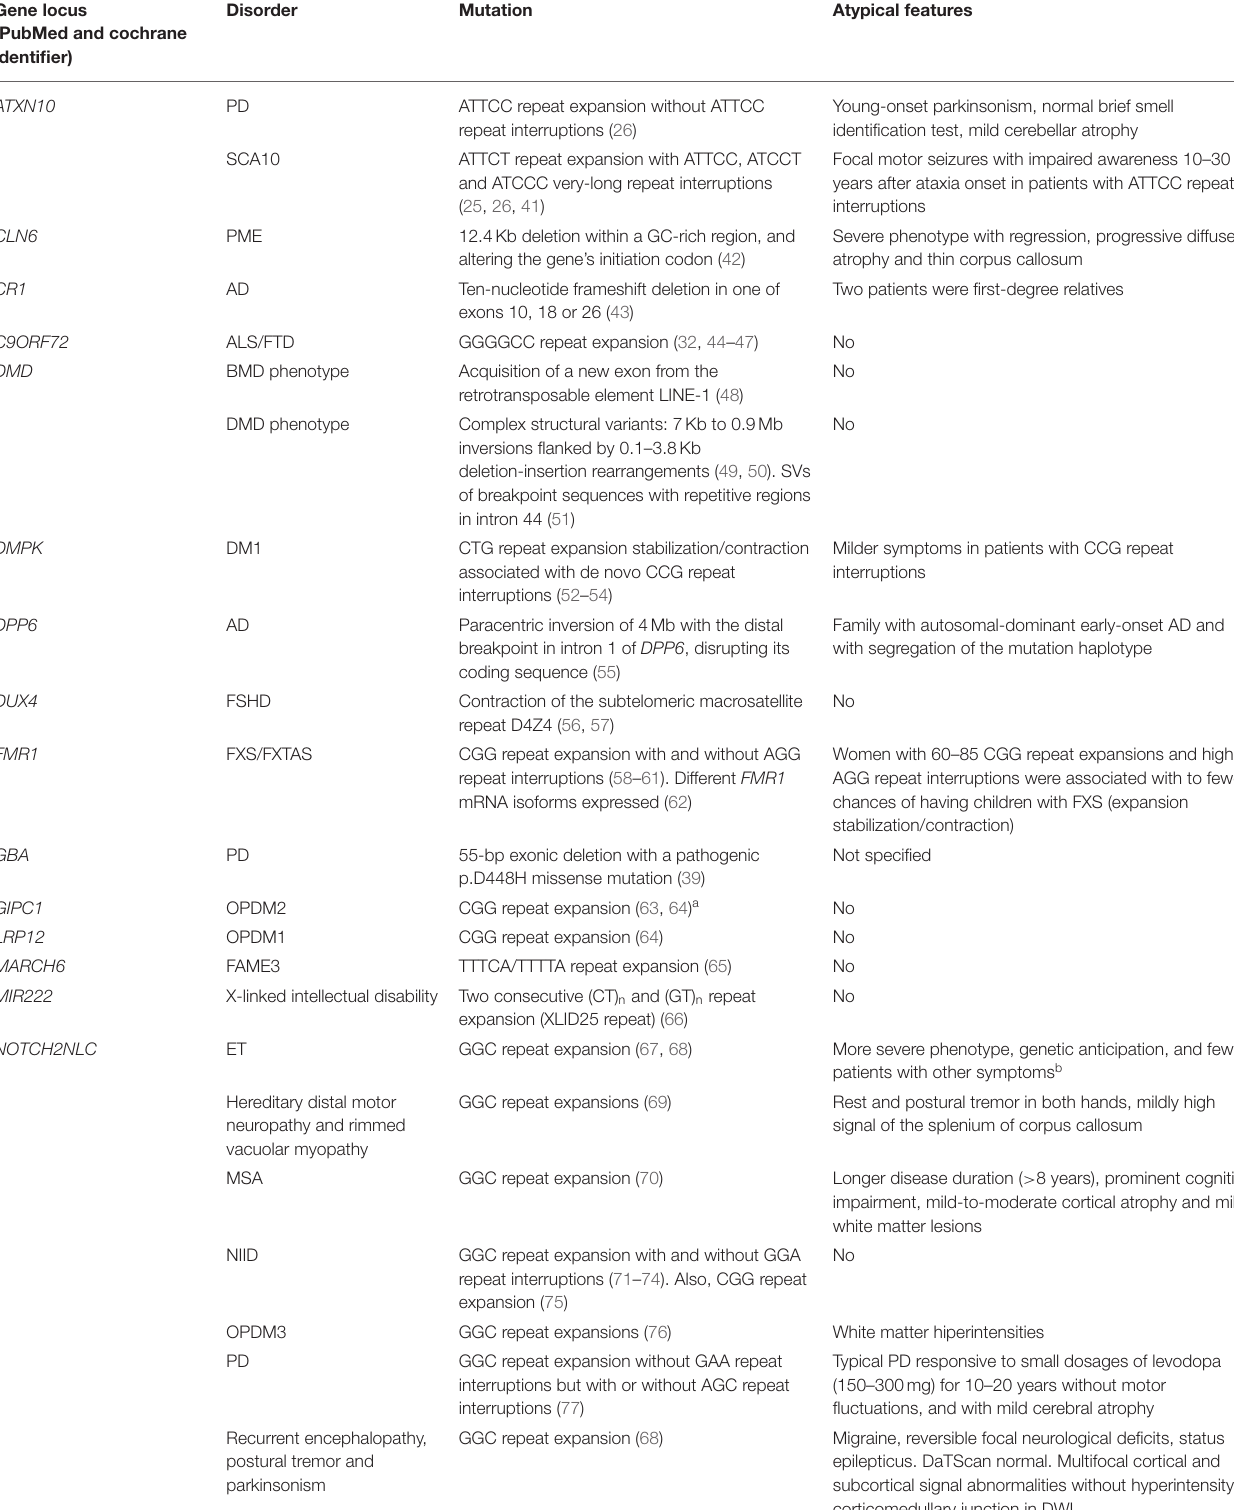
TABLE 2 | Mutations previously hidden from standard genetic techniques but resolved after long-read sequencing a . Gene locus (PubMed and